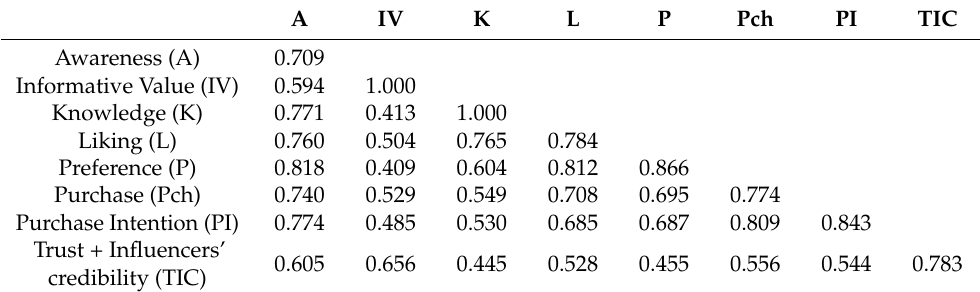
Table 3. Discriminant validity (Fornell and Larker a ).